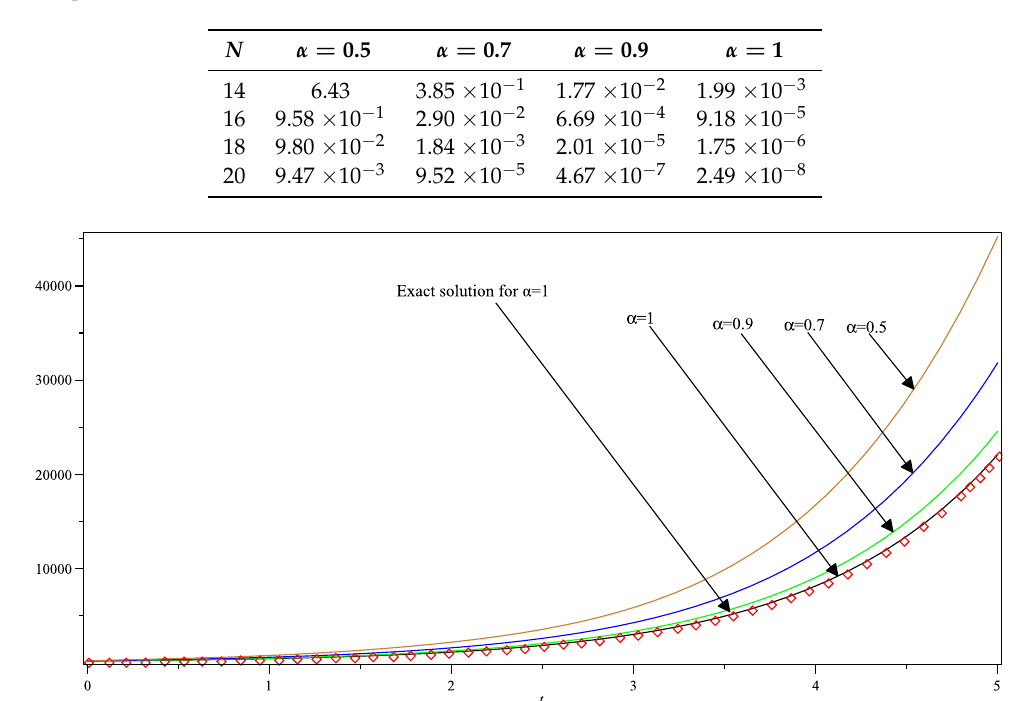
Figure 1. Plots of seventh-order approximation solutions by present method at x = 5 for different values of α in Example